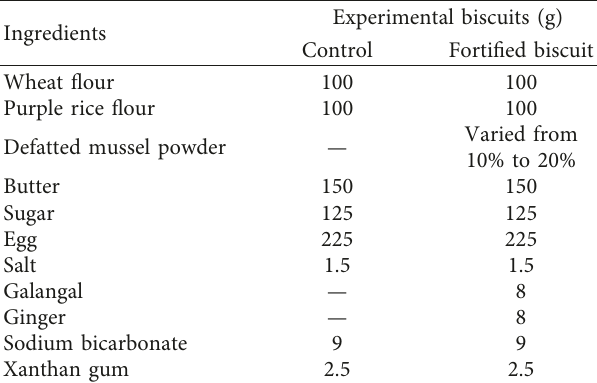
Table 1: Formulation of control and fortified biscuits.